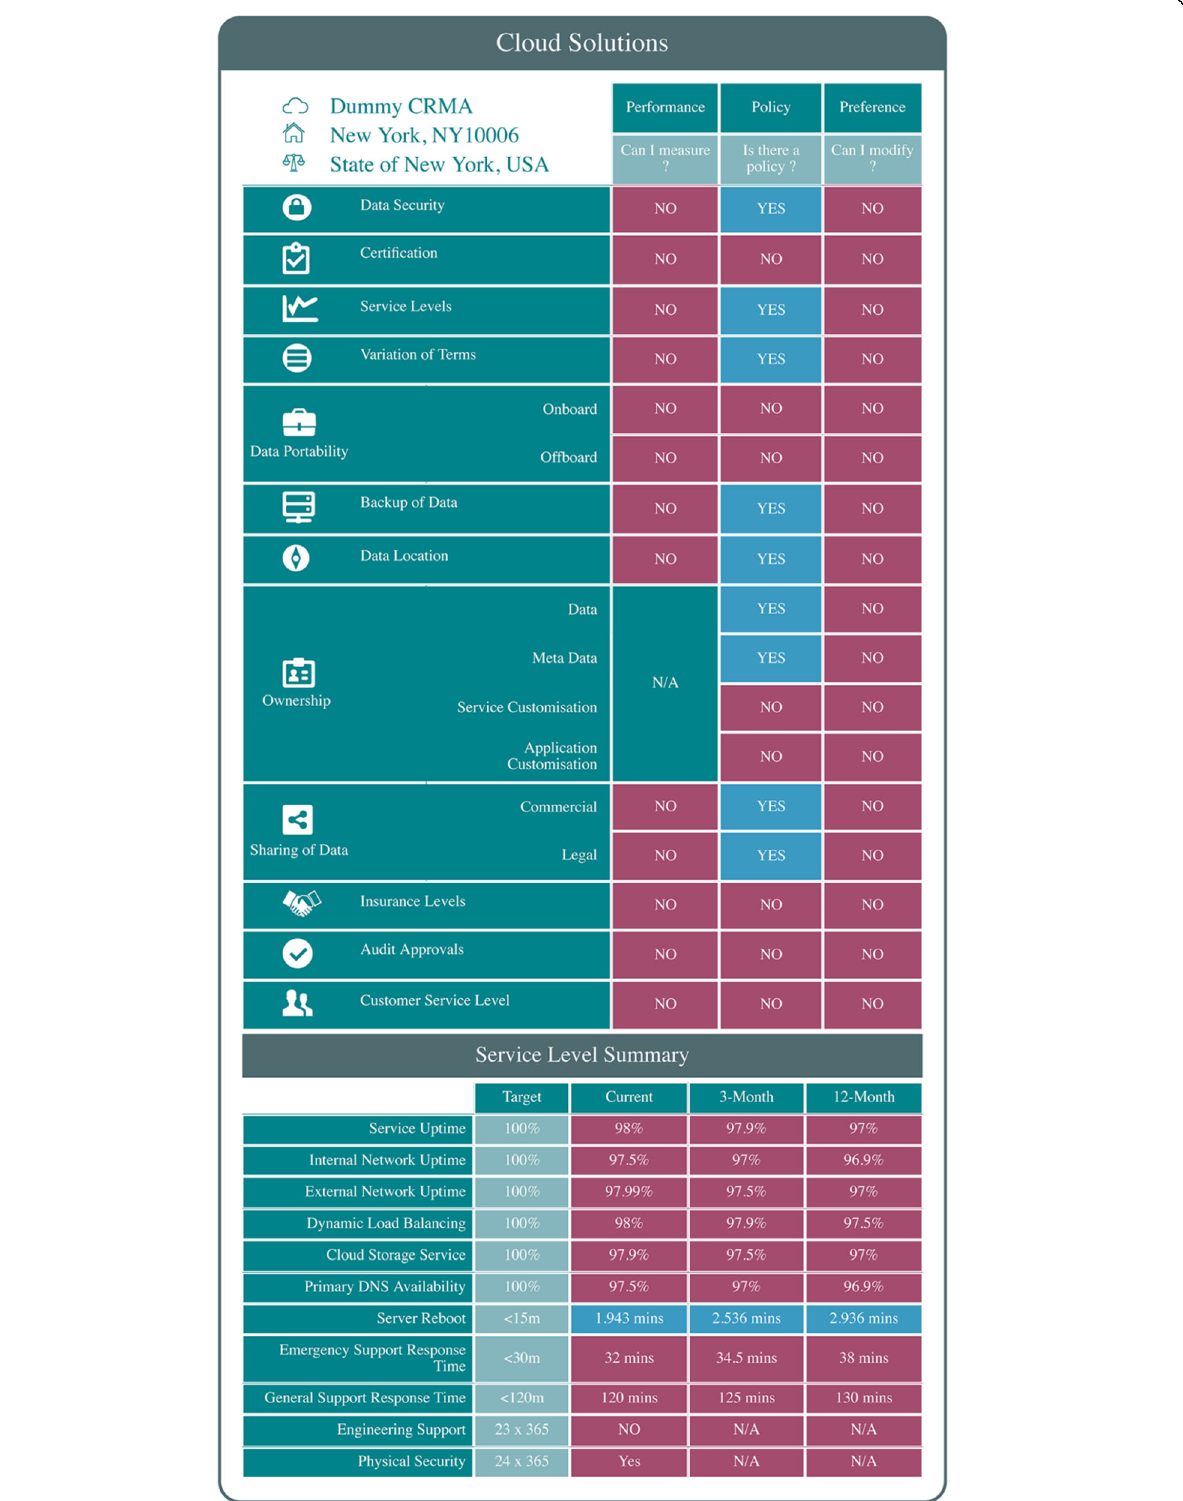
Fig. 2 Exemplar Negative CTL. An exemplar negative CTL was developed to explore the influence of negative information regarding the CSP on individuals ’ trust